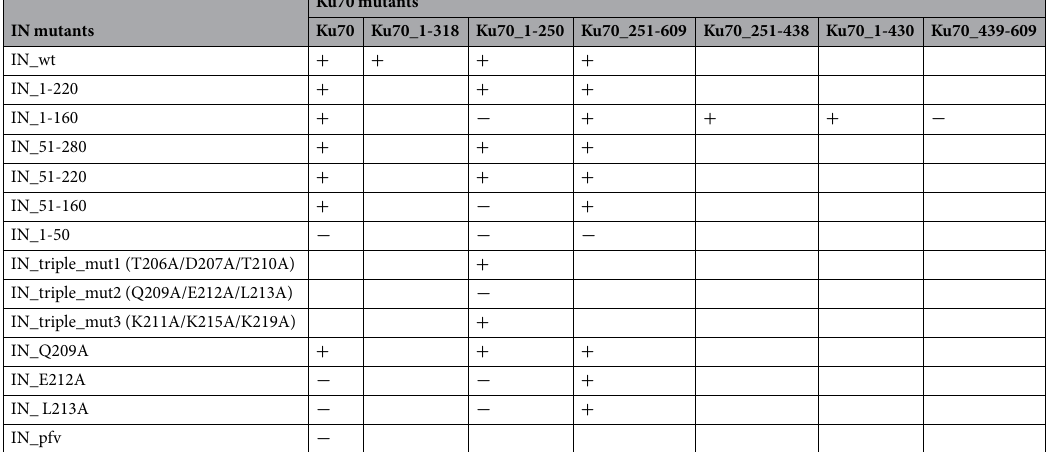
− Table 1. Wild type and mutant proteins used in the present work and the results of pull-down experiments showing the structural elements important for the IN/Ku70